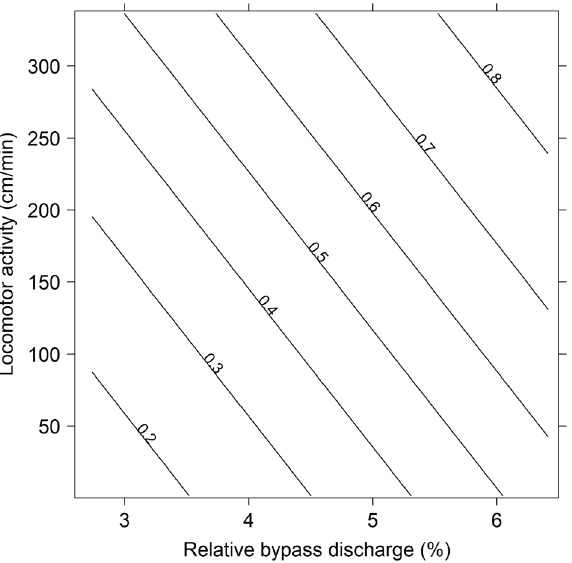
Figure 2. Predicted fish passage migration probability for Atlantic salmon smolts at Rygene hydropower plant as a function of locomotor activity (distanced swam per min during the 20-min basal locomotion activity assay) and percent discharge allocated to the fish passage in relation to the turbine intake. Probability predictions, displayed as isolines, were derived from the most supported binomial GLM, as reported in Table